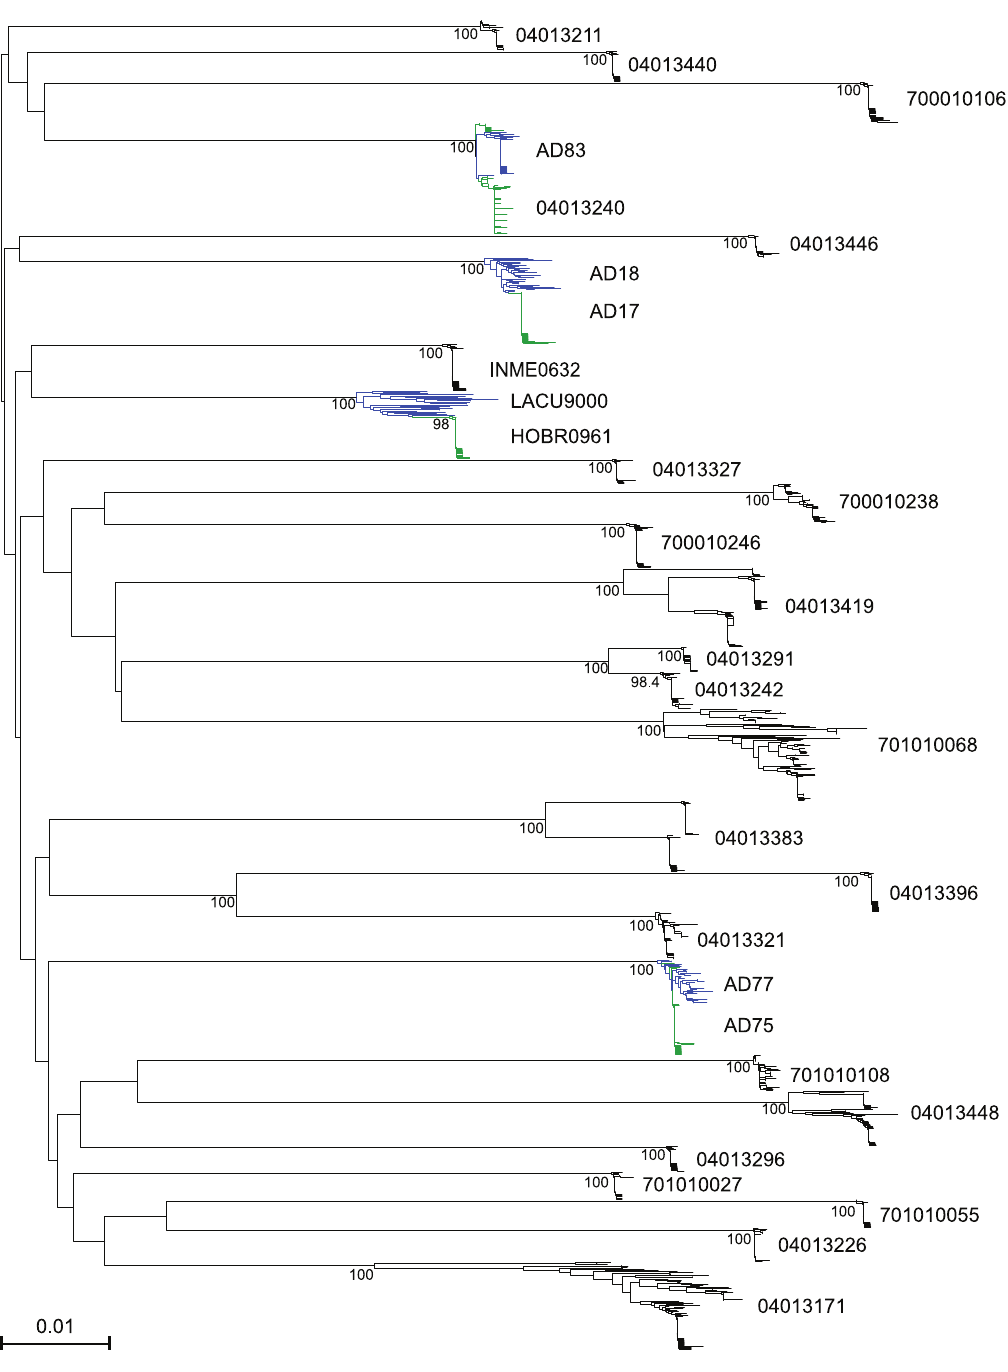
Figure 1. Neighbor-joining (NJ) tree of full-length HIV-1 gp160 env sequences from 28 acutely infected subjects and 2 chronically infected sexual partners. Two chronic-to-acute (LACU9000 to HOBR0961 and AD18 to AD17) and two acute-to-acute (AD77 to AD75 and AD83 to 04013240) transmissions were documented, with donor sequences shown in blue and recipient sequences shown in green. Individual sequences with APOBEC G-to-A hypermutation were excluded from the analysis. Bootstrap values ( $ 70%) are shown for intra-subject clusters, partner pairs, and additional sequences with evidence of epidemiologic linkage. The horizontal scale bar represents 1.0% genetic distance.